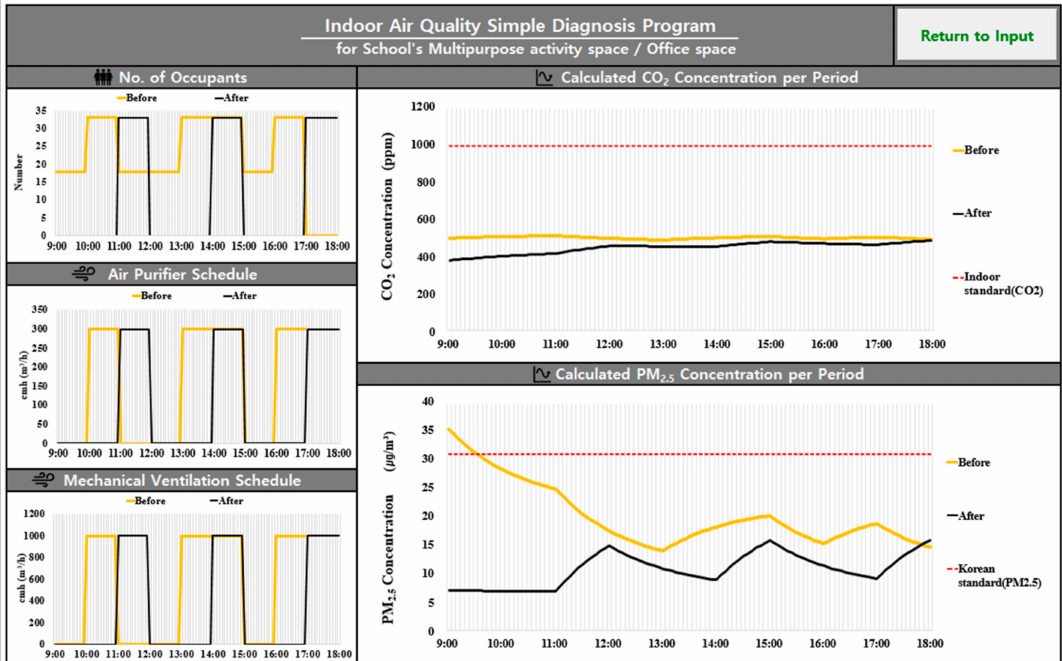
Figure 13. Result sheet of the simple indoor air quality diagnosis program for office and multipurpose activity spaces at